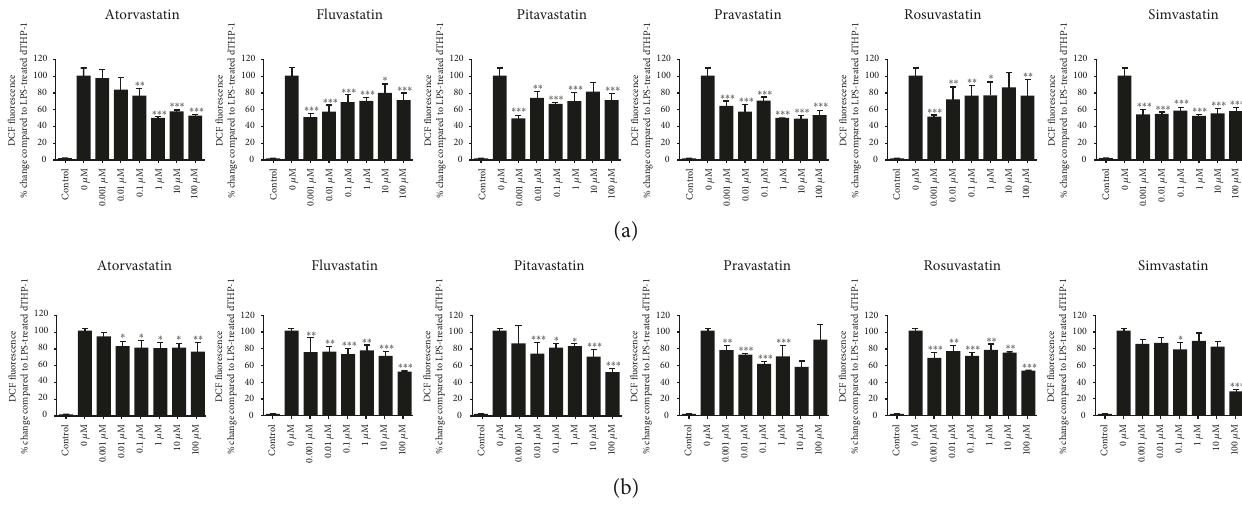
Figure 3: Statin-induced changes in (a) DCF fl uorescence, as a measure of global ROS production, and (b) DAF fl uorescence, as a measure of nitric oxide release, in LPS-activated dTHP-1 cells. Cells were pretreated for 24 h with one of the six statins (0 – 100 μ M) prior to receiving a 24h LPS stimuli, after which time DAF and DCF fl uorescence were measured. Statin-treated data is represented as mean+ SD; vehicle control (0 μ M) is represented as mean+ SEM. All values represent the results from three independent experiments. ∗ Statin treatment versus LPS